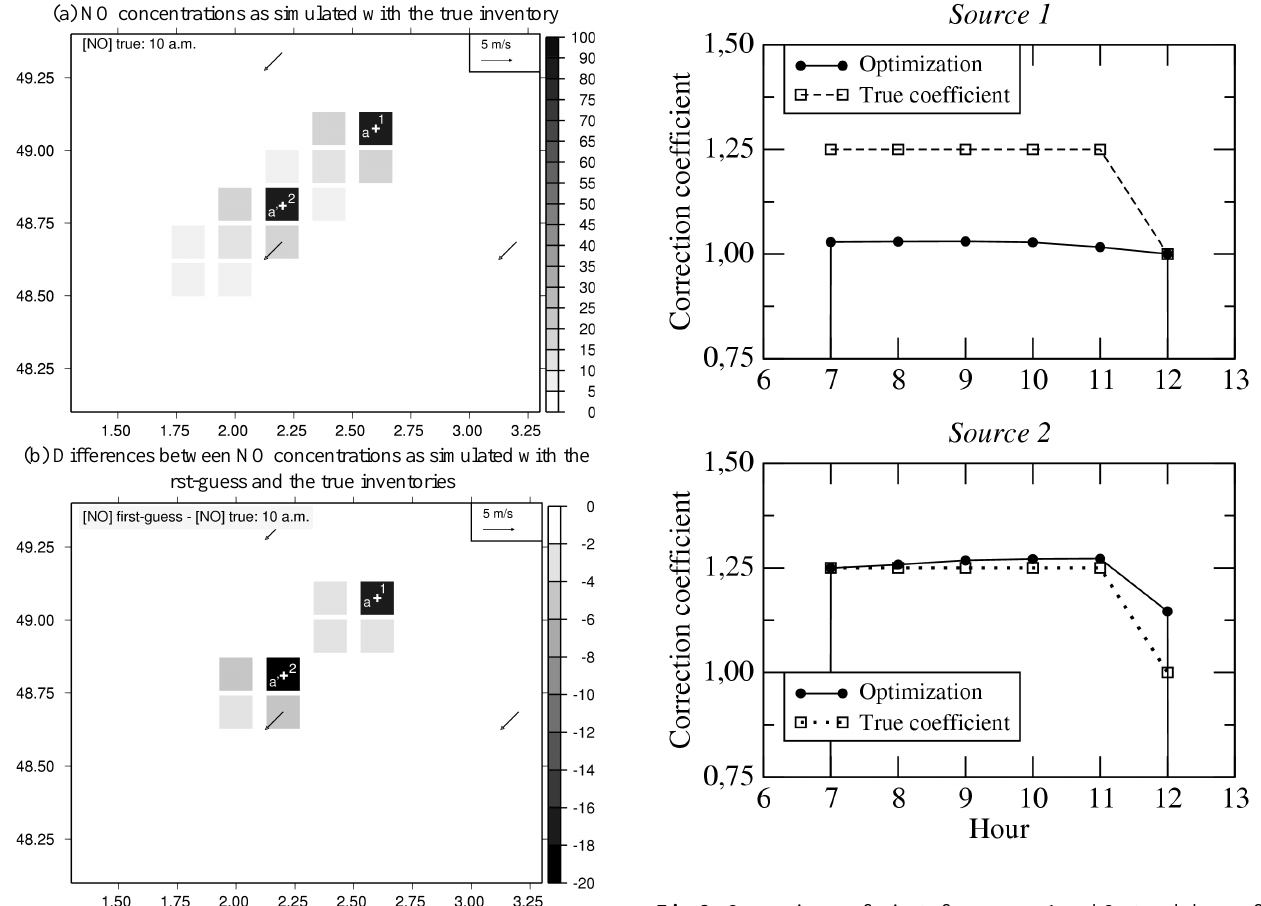
Fig. 3. Correction coefficients for sources 1 and 2 at each hour of the time window for Test Case #2